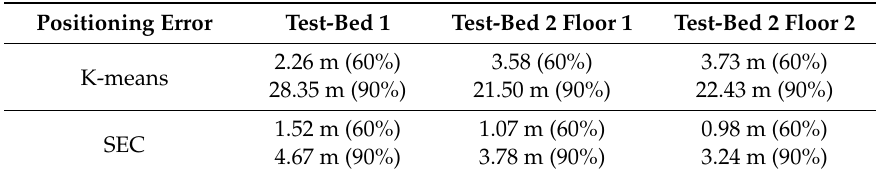
Figure 12. Positioning performance comparison between K-means and SEC in Cumulative Distribution Function (CDF) of positioning error under MWKNN matching algorithm: ( a ) CDF comparison in Test-bed 1; ( b ) CDF comparison in Test-bed 2 Floor 1; and ( c ) CDF comparison in Test-bed 2 Floor 2. Table 3. Positioning Performance Comparison between K-means and SEC under Modified Weight K Nearest Neighbor (MWKNN)